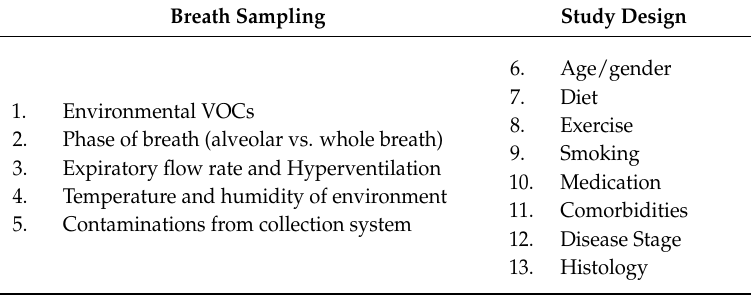
Table 2. Methodological Issues of Clinical Studies.